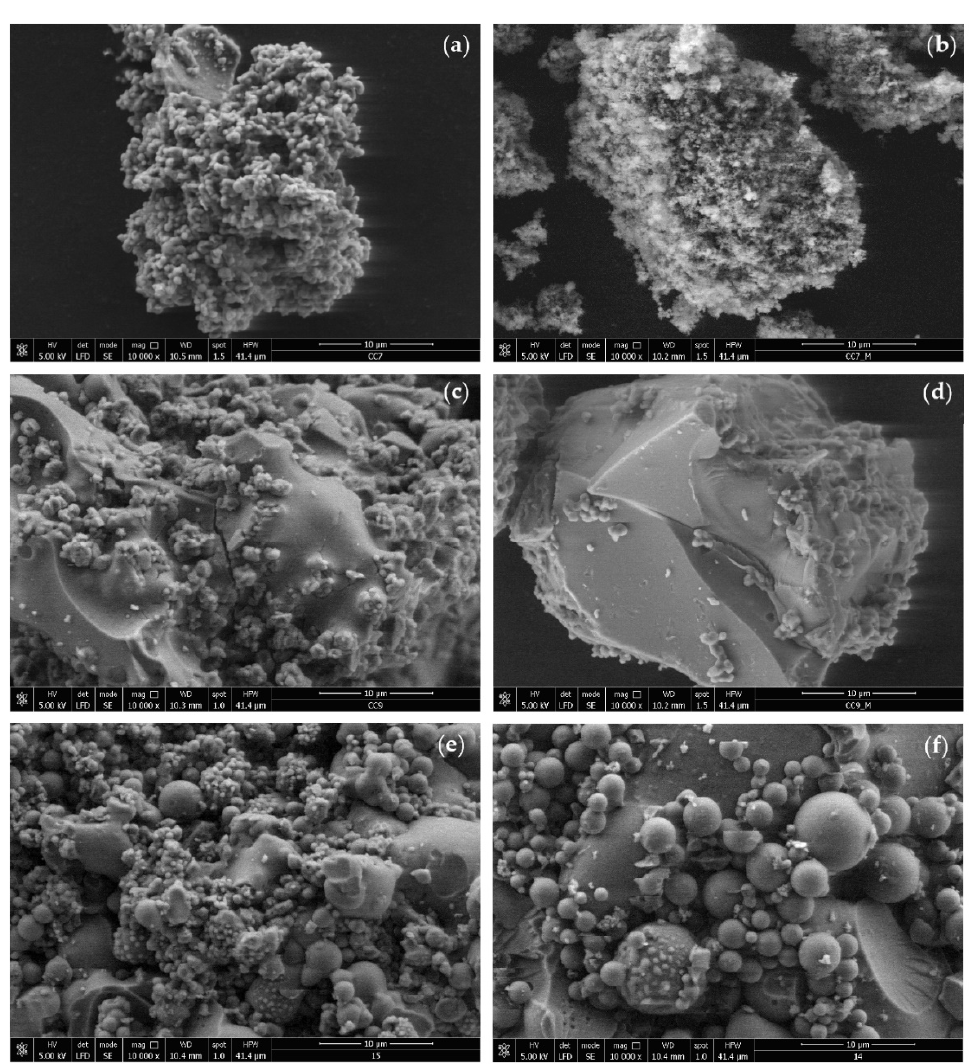
Figure 3. SEM micrographs at 10,000 × magnification of the sol–gel entrapped cellulase biocatalysts and the blank sol–gel matrix: ( a ) SG6—PhTMOS:TMOS (1:1); ( b ) Blank-SG6—PhTMOS:TMOS (1:1);